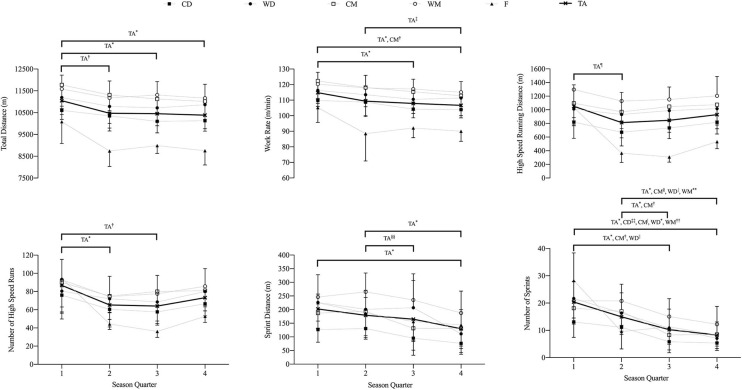
Team average and positional physical performance by season quarter: CD, central defenders; WD, wide defenders; CM, central midfielders; WM, wide midfielders; F, forwards; TA, team average. Data are presented as mean ± SD. Horizontal lines and symbols denote differences within groups: *P = 0.001;
†P = 0.002;
‡P = 0.003;
§P = 0.004;
|P = 0.005;
¶P = 0.006; **P = 0.007; P = 0.012;
‡‡P = 0.014;
§§P = 0.035;
||P = 0.044.